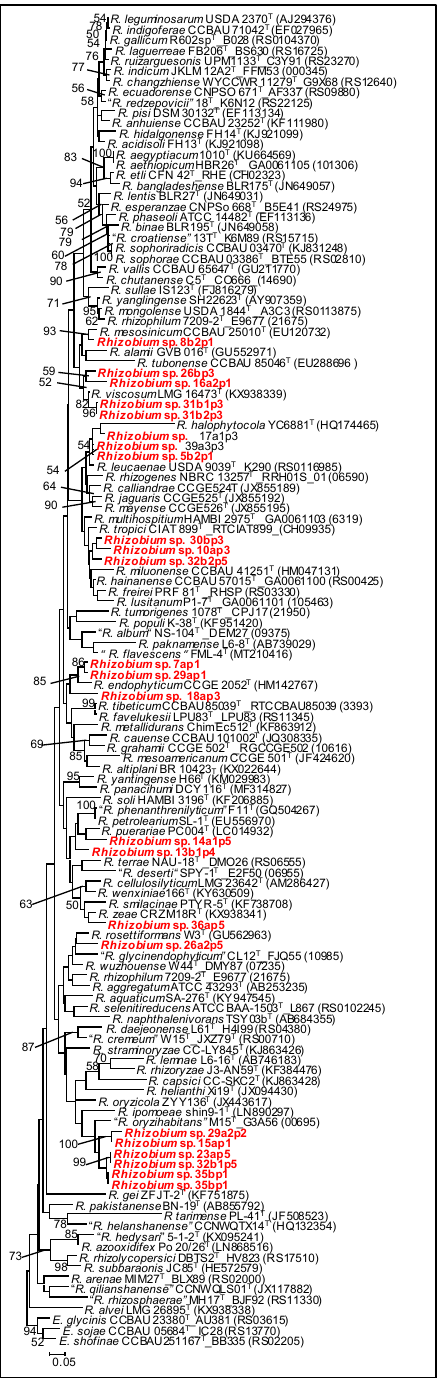
Figure 6. A recA maximum-likelihood phylogeny of Rhizobium strains associated with pigeonpea. The strains in red originated from pigeonpea nodules. Bootstrap support for the groupings above 50% are indicated. Information regarding the type strain is provided while the GenBank accession number or locus tag for each species is indicated in brackets. Species names which appear in inverted commas (‘ . . . ’) are combinations which have not yet been validly published. The scale bar corresponds to the number of nucleotide changes per site. The model used is GTR + I + G with invariable proportion site value 0.4310 and gamma value 0.8190.